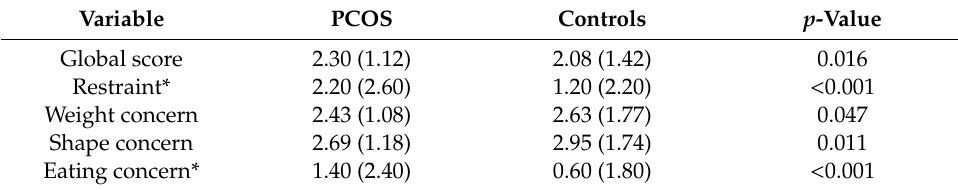
Table A2. EDE-Q global score and sub scores in women with and without